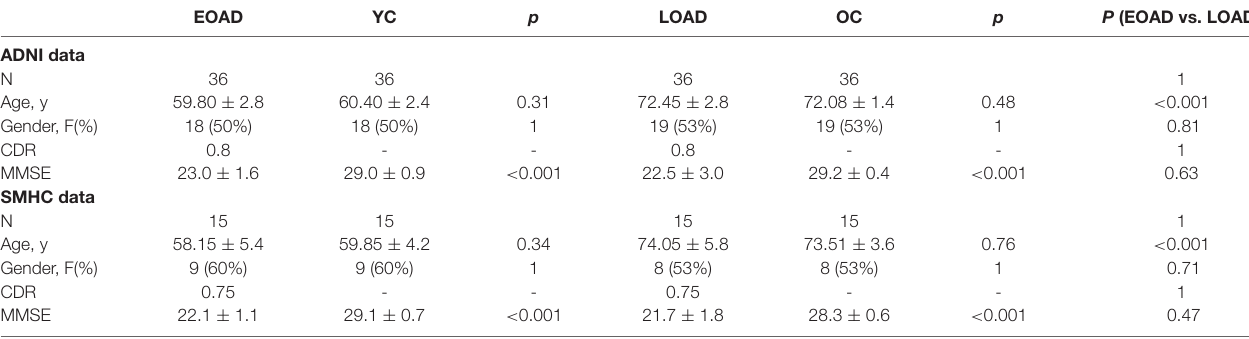
TABLE 1 | Demographic, clinical parameters for EOAD, LOAD, YC, and OC subjects. EOAD YC p p P (EOAD vs. LOAD)